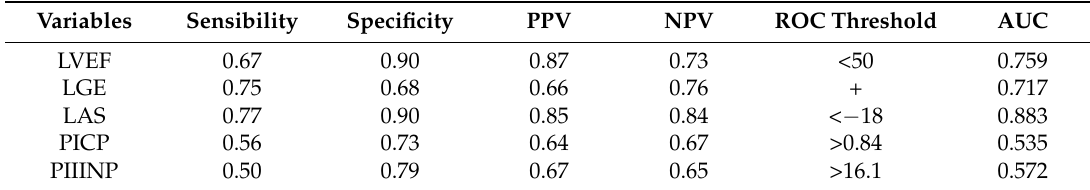
Table 3. Predictive ability of biological markers and imaging parameters for outcomes in severe AS patients considered for aortic valve replacement